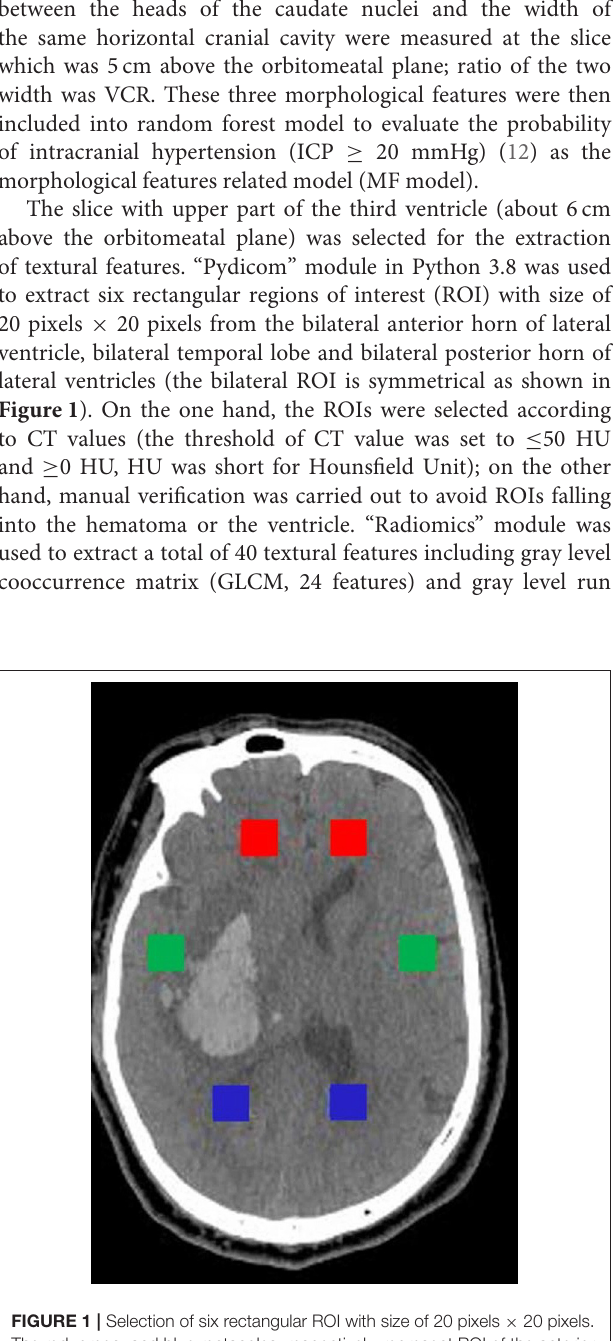
FIGURE 1 | Selection of six rectangular ROI with size of 20 pixels × 20 pixels. The red, green, and blue rectangles, respectively, represent ROI of the anterior horn, the temporal lobe, and the posterior